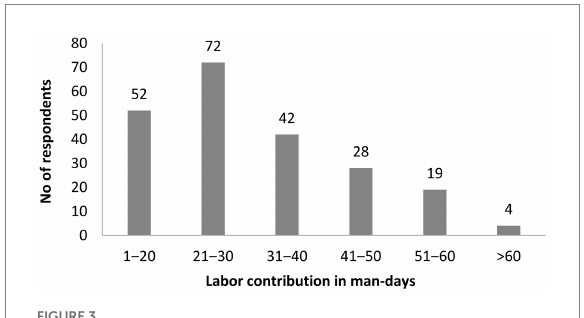
FIGURE 3 Annual maximum willingness to contribute labor (in man-days) for improving Lake Tana ecosystem